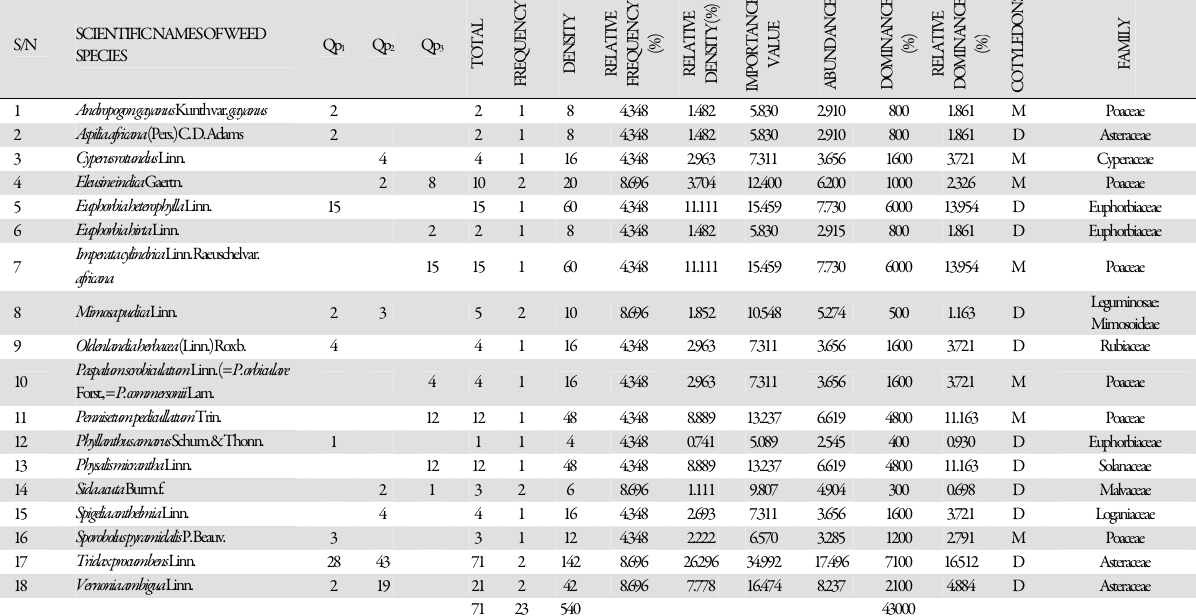
Tab. 6. Weed flora and species parameter for pepper plot at 6WAP